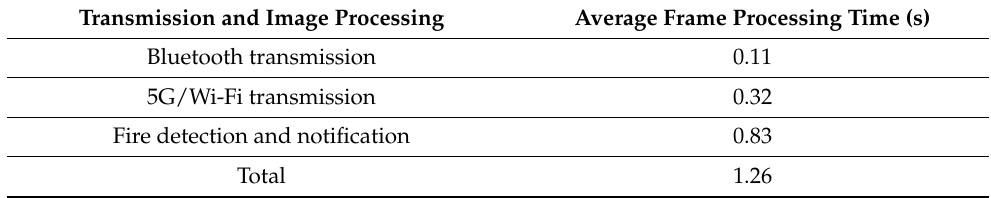
Table 6. Average frame processing time (in seconds) for each sequence. Table 7. Evaluation of the effectiveness of fire detection using different